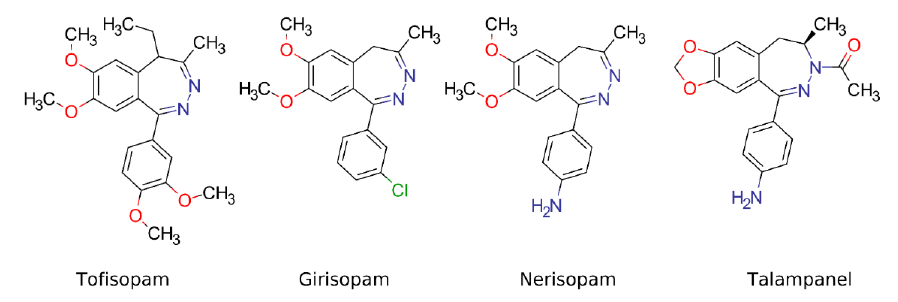
Figure 1. 2,3-Benzodiazepines with anxiolytic activity.